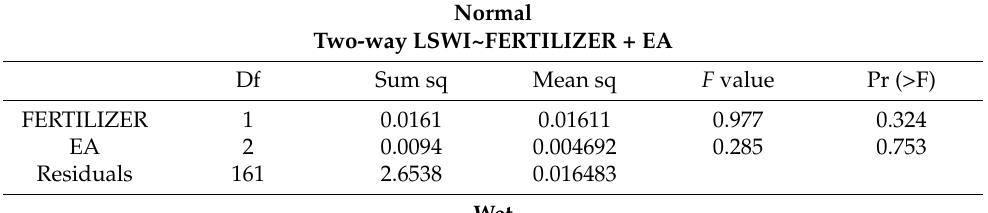
Table 4. Two-way ANOVA results for fertilizer (broiler litter or inorganic) and endophyte associations (EA; free, novel, or wild).